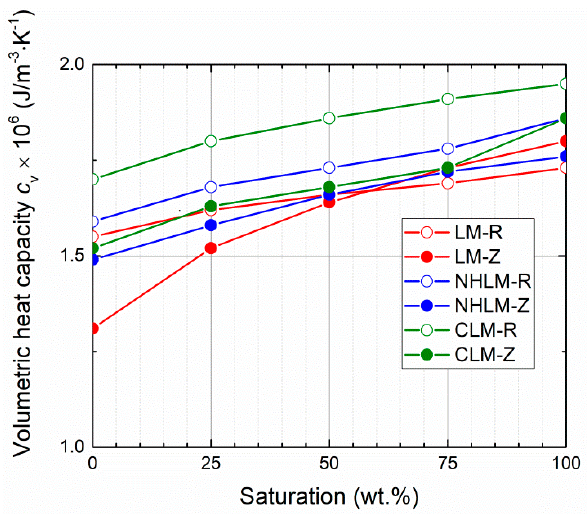
Figure 7. Moisture-dependent volumetric heat capacity—28-day samples.